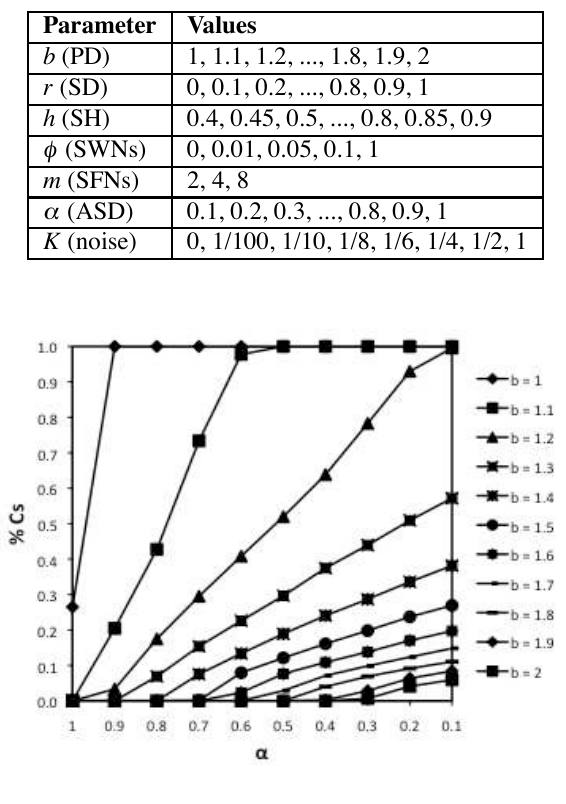
Fig. 1. Proportion of Cs for the PD game on SFNs with m = 2 and with K =